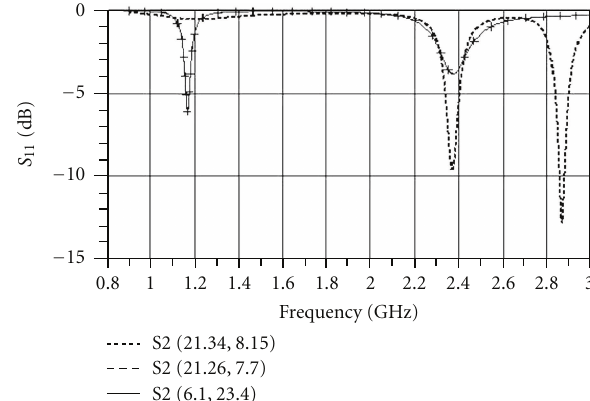
Figure 3: Comparison between di ff erent feed positions for second iteration (S3).